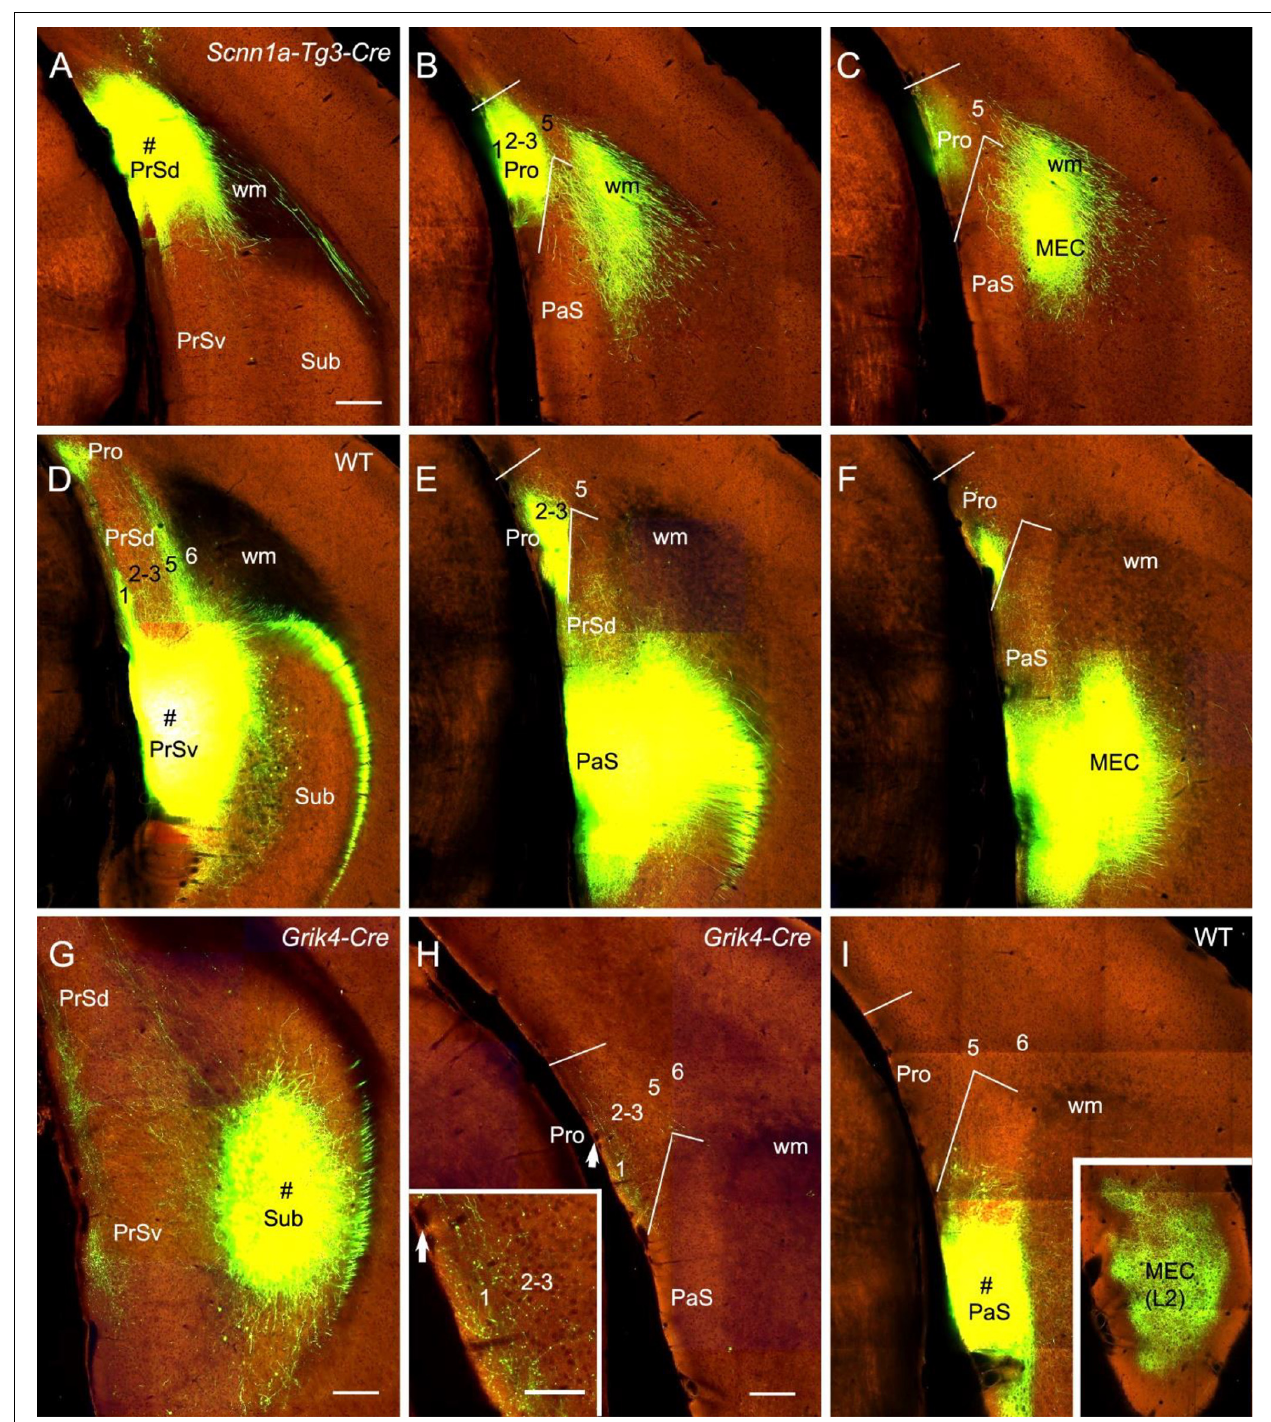
FIGURE 8 | Projections from subicular cortices to the Pro. ( A–C) An injection in the PrSd (i.e., PoS; # in A ) of one Scnn1a -Tg3-Cre mouse (Cre expression in L2–3) results in strong terminal labeling in L1–3 of the Pro and the MEC (B,C) . ( D–F) An injection in the PrSv (# in D ) of one WT mouse leads to strong terminal labeling in L1–3 of the Pro and the MEC (E,F) . Note that the PrSv axons reach the Pro through L1 of the PrS and reach the MEC through the PaS. In contrast, PrSd axons reach the MEC via the white matter (wm). (G,H) An injection in the Sub (# in G ) of a Grik4 -Cre mouse (Cre in Sub) leads to moderate terminal labeling in L1–3 of the Pro (H) . The Pro labeling in panel (H) is magnified in the inset. Arrows in the Pro point to corresponding locations. (I) An injection in the PaS (# in I ) of WT mouse produces no terminal labeling in the Pro but strong labeling in L2 of the MEC (inset). Bars: 280 µ m in (A) (for A–F ); 350 µ m in (G) ; 200 µ m in (H) (also for (I) and the inset in I ); 100 µ m in the inset in (H)